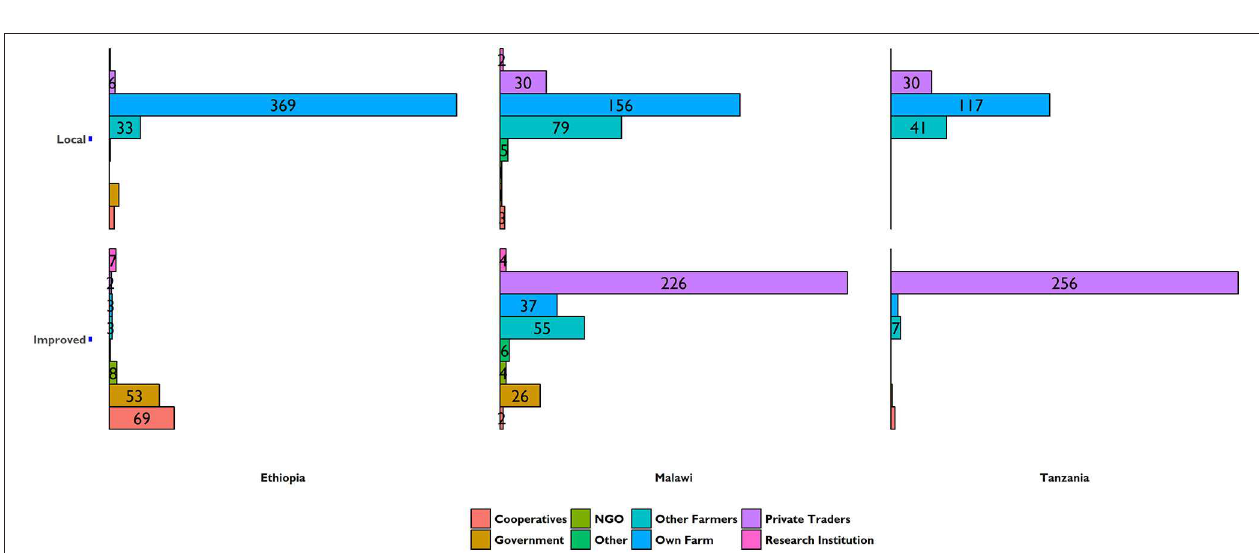
FIGURE 2 | Seed sources for local and improved maize at the study sites in Ethiopia, Malawi, and Tanzania.